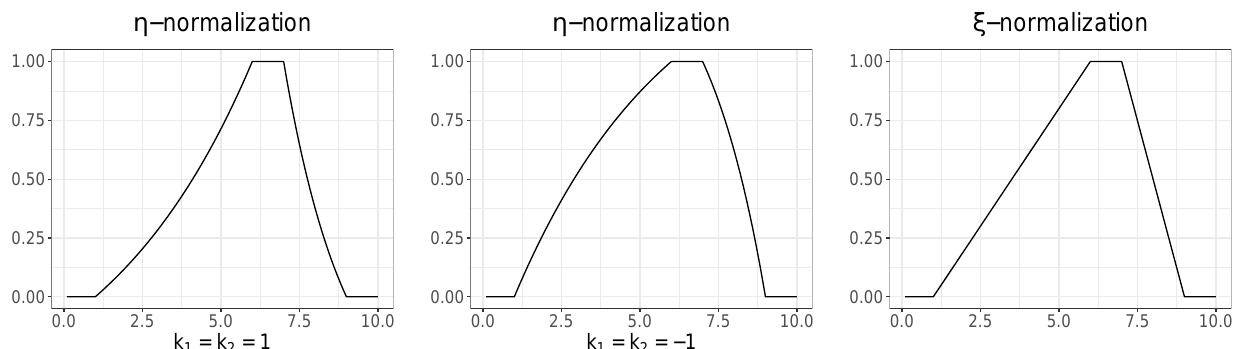
1. Finally, − = k = 1, 2 1 = k = 1 and the third is the normalization ξ . 2 1 −